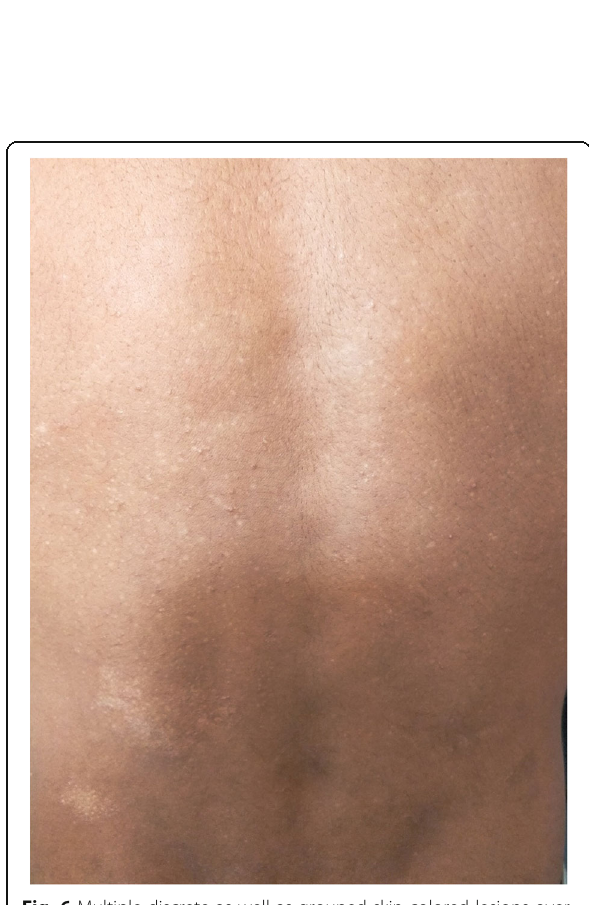
Fig. 6 Multiple discrete as well as grouped skin-colored lesions over the trunk and